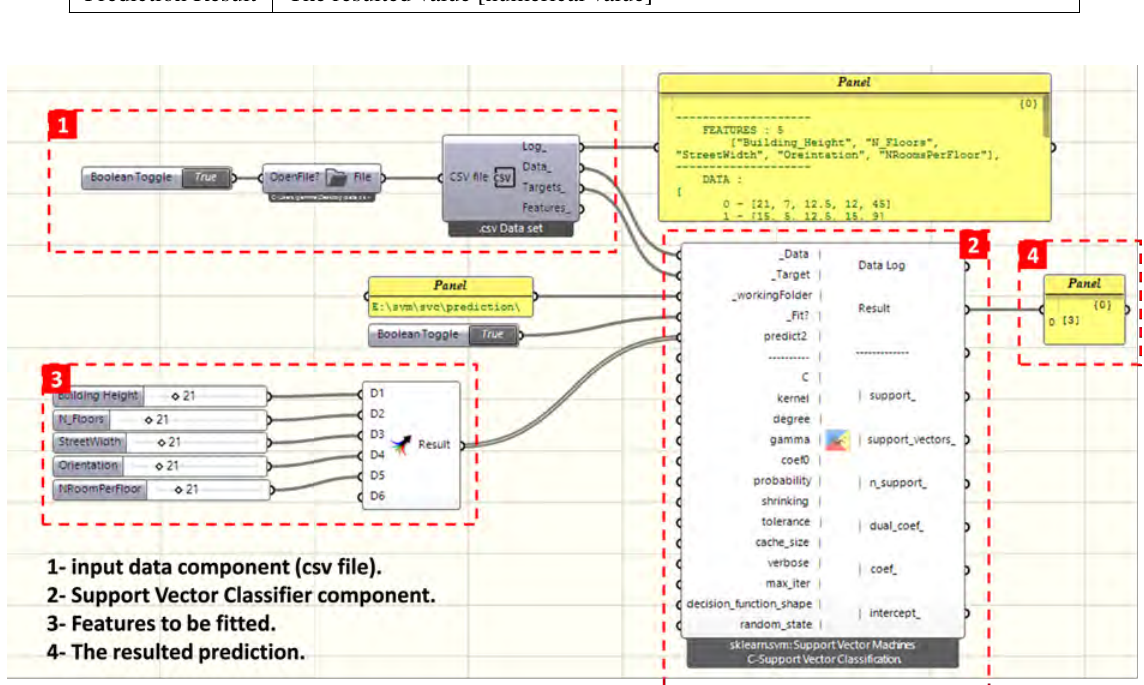
Figure 5. An example of classifier component (support